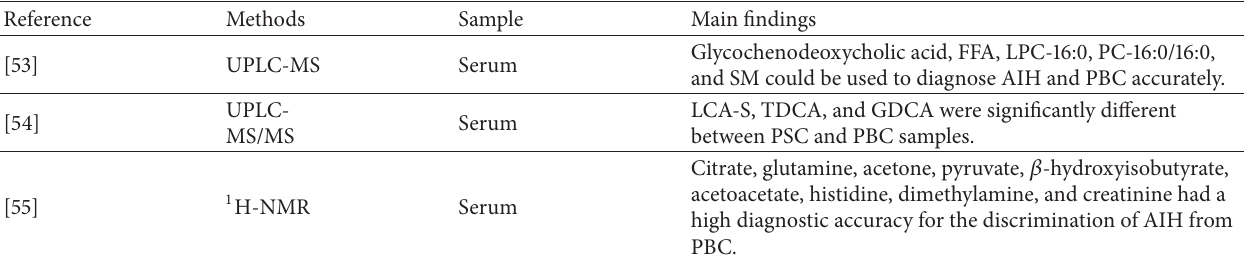
Table 8: The main results of studies on autoimmune liver